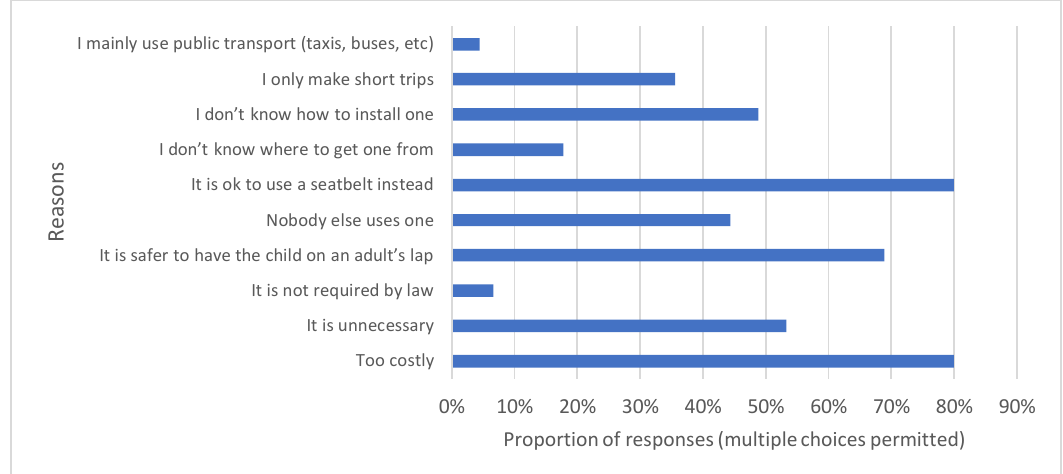
Figure 4. Reasons for not owning a child restraint amongst survey respondents. Reasons for not owning a child restraint system.